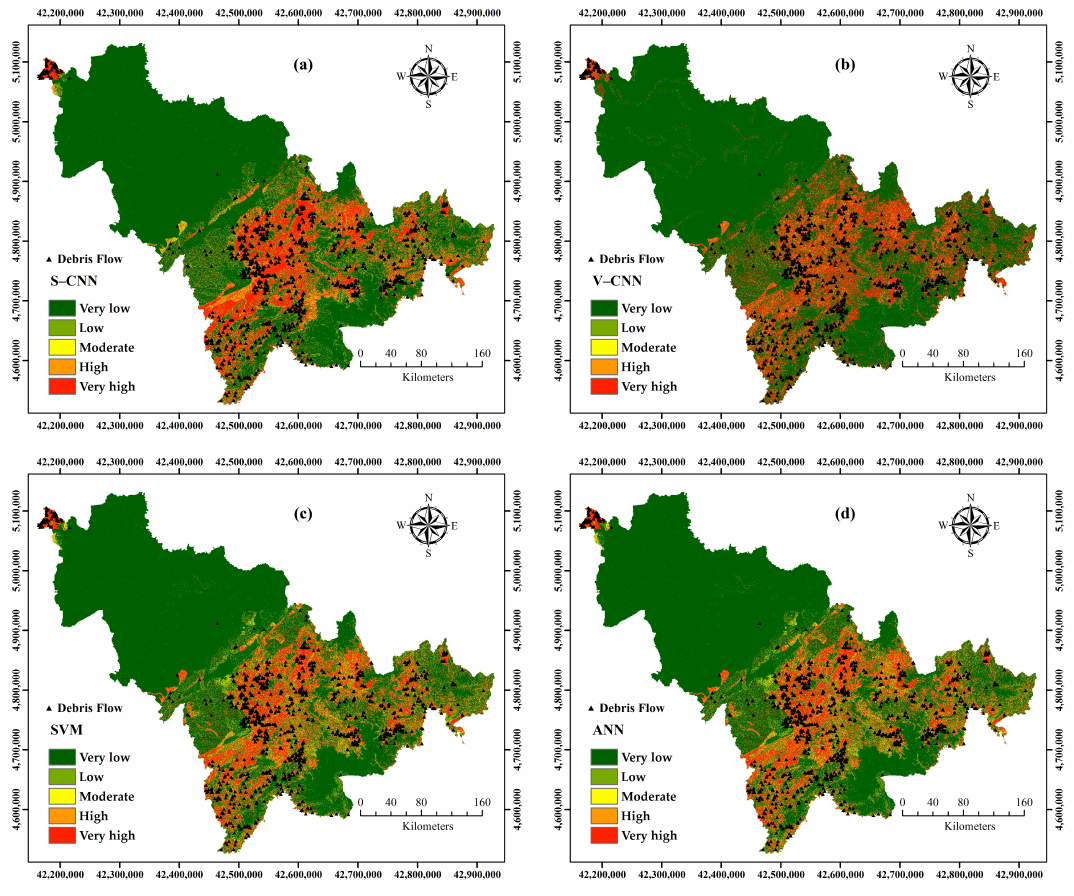
Figure 14. Debris flow susceptibility maps: ( a ) 2D–CNN based on SAME padding (S–CNN), ( b ) 2D–CNN based on VALID padding (V–CNN), ( c ) Support Vector Machines (SVM), ( d ) Artificial Neural Network